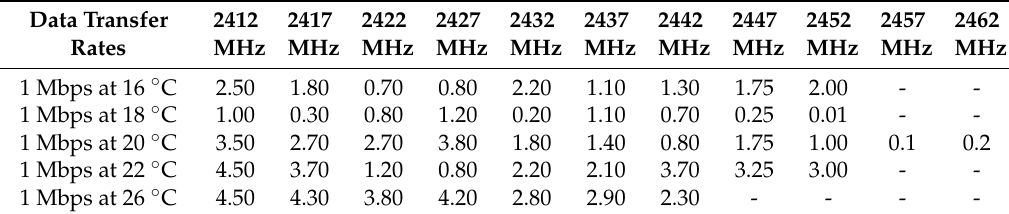
Table 4. Calculation of residuals for BPSK.